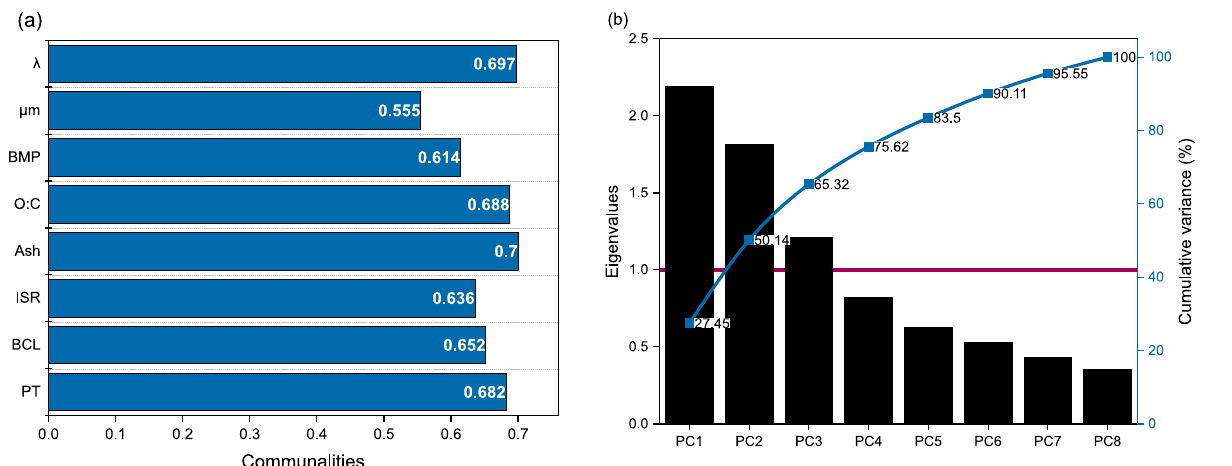
Figure 1. Results of the principal component analysis (PCA): ( a ) Communalities for the variance of each variable explained by the PCA; ( b ) Scree plot of the principal components (PCs) outlining the Eigenvalues and variance of the dataset. The PCs are the linear depiction of the original dataset and the total variance of the eight variables.